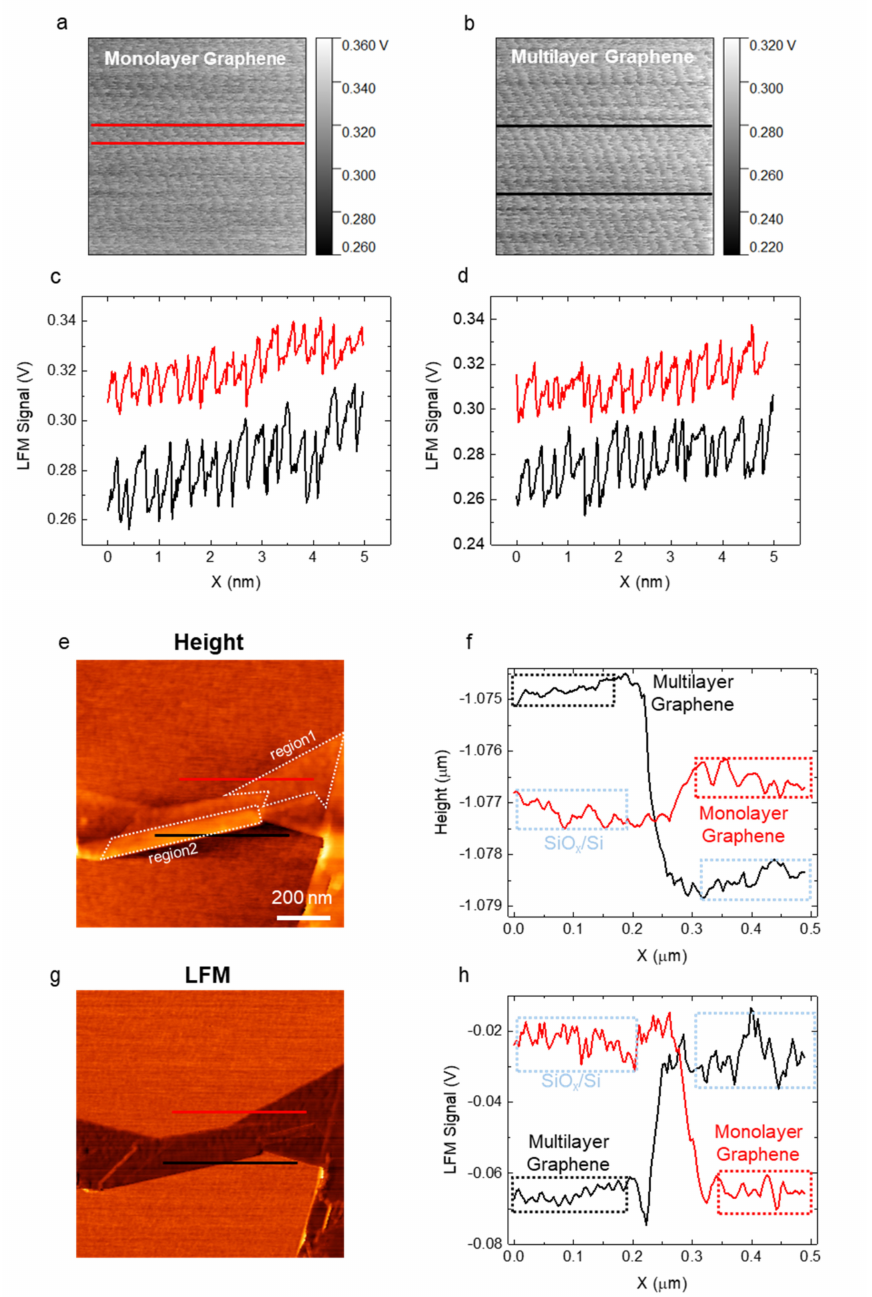
Figure 7. Demonstration of substrate roughness effect. ( a ) High-resolution LFM raw (unflatten and unfiltered; color range adjusted) image of monolayer graphene acquired at a scan size of 50 Å, a scan rate of 22.12 Hz, and a load of 3.4 nN; ( b ) high-resolution LFM raw (unflatten and unfiltered) image of multilayer graphene acquired at a scan size of 50 Å, a scan rate of 22.45 Hz, and a load of 2.9 nN. ( a , b ) were obtained using the same atomic force microscopy (AFM) probe; ( c , d ) comparison of cross-sectional profiles along the red (monolayer) and black (multilayer) lines in ( a , b ); ( e ) height image of graphene; ( f ) comparison of cross-sectional profiles along the red and black lines in ( e ); ( g ) LFM image of graphene; ( h ) comparison of cross-sectional profiles along the red and black lines in ( g